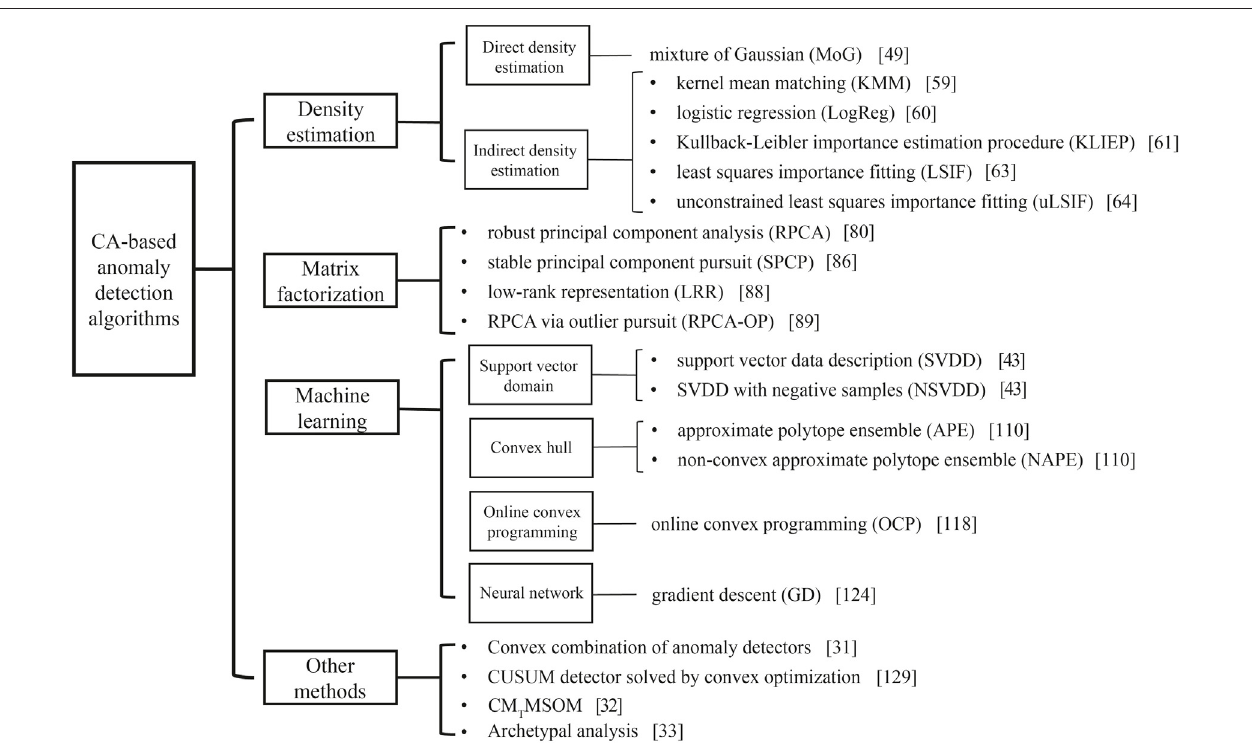
FIGURE 3 | Anatomy of CA-based anomaly detection methods and their cornerstone